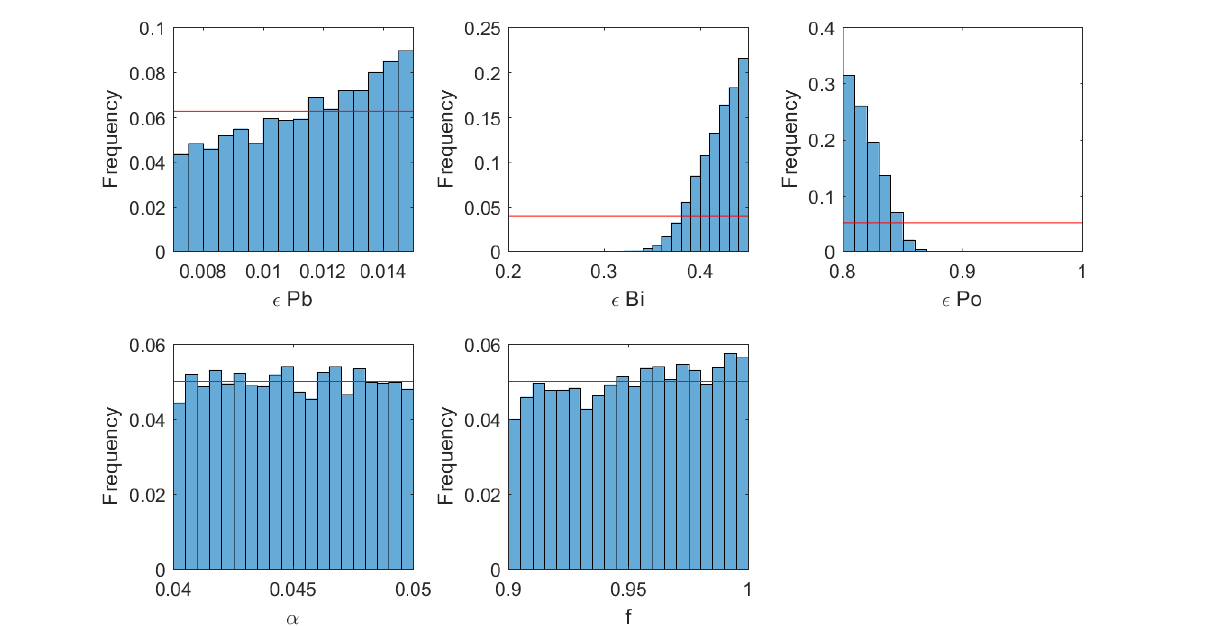
Figure 5. Histograms of the model parameters ( α , f , (cid:101) Pb , (cid:101) Bi , (cid:101) Po ) for which the model can explain the measurements. The horizontal bar represents the uniform law used to generate random values. This line corresponds to the theoretical histogram that would be obtained for a parameter having no influence on the production of simulated results matching measured activity ratios. Its frequency is not relevant in itself and is merely equal to the reciprocal of the number of bars in the